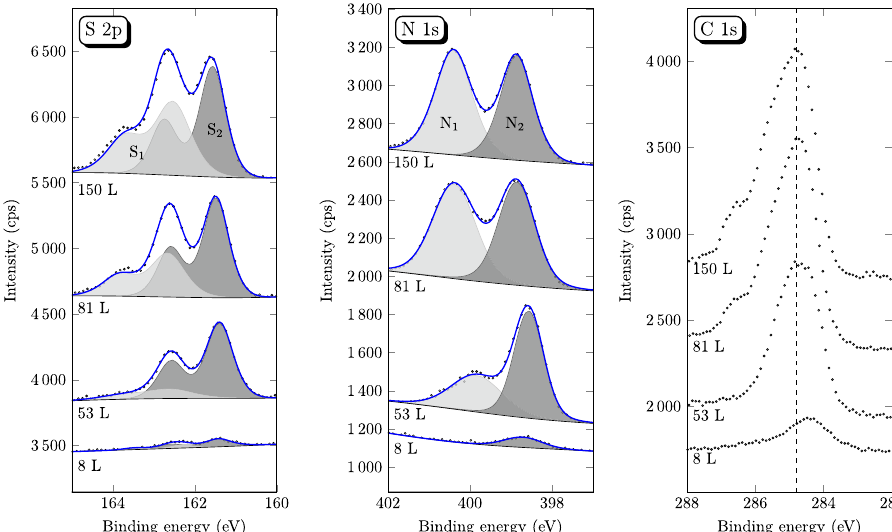
Fig. 3 High resolution XPS spectra obtained after 2-MBI exposure on the metallic Cu(111) surface at ultra-low pressure and RT. The S 2p, N 1s and C 1s core levels.